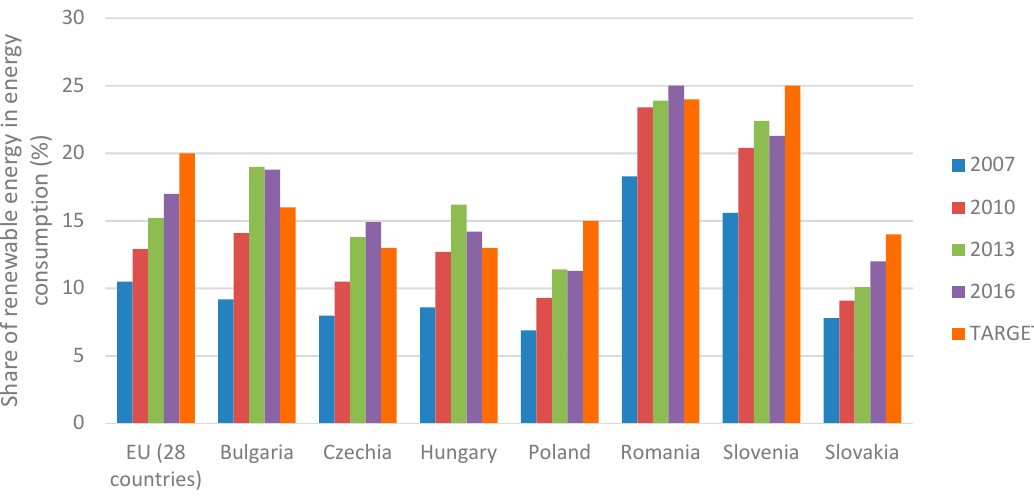
Figure 7. Share of renewable energy in energy consumption, Source: Own representation based on EUROSTAT data [12].